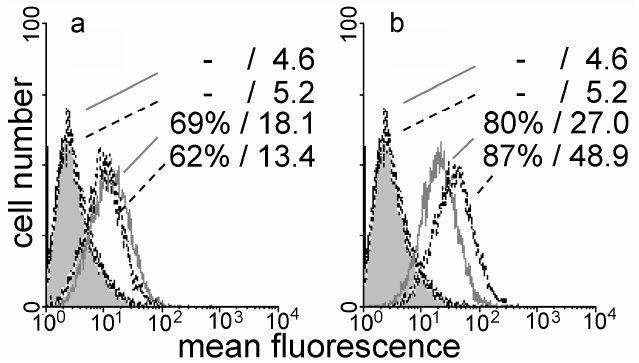
Figure 7. Flow cytofluorometric analysis of binding of labeled Gal-8 (NN) (40 µ g/mL) ( a ) and Gal-8 (NC) (20 µ g/mL); ( b ) to the surface of parental (grey line) and of neuraminidase-treated CHO cells (dashed line). Numbers in each panel denote percentage of positive cells/mean fluorescence intensity for controls (without/with neuraminidase treatment) and the respective lectin-dependent stainings. Control profiles for lectin-independent background are shown as grey area.